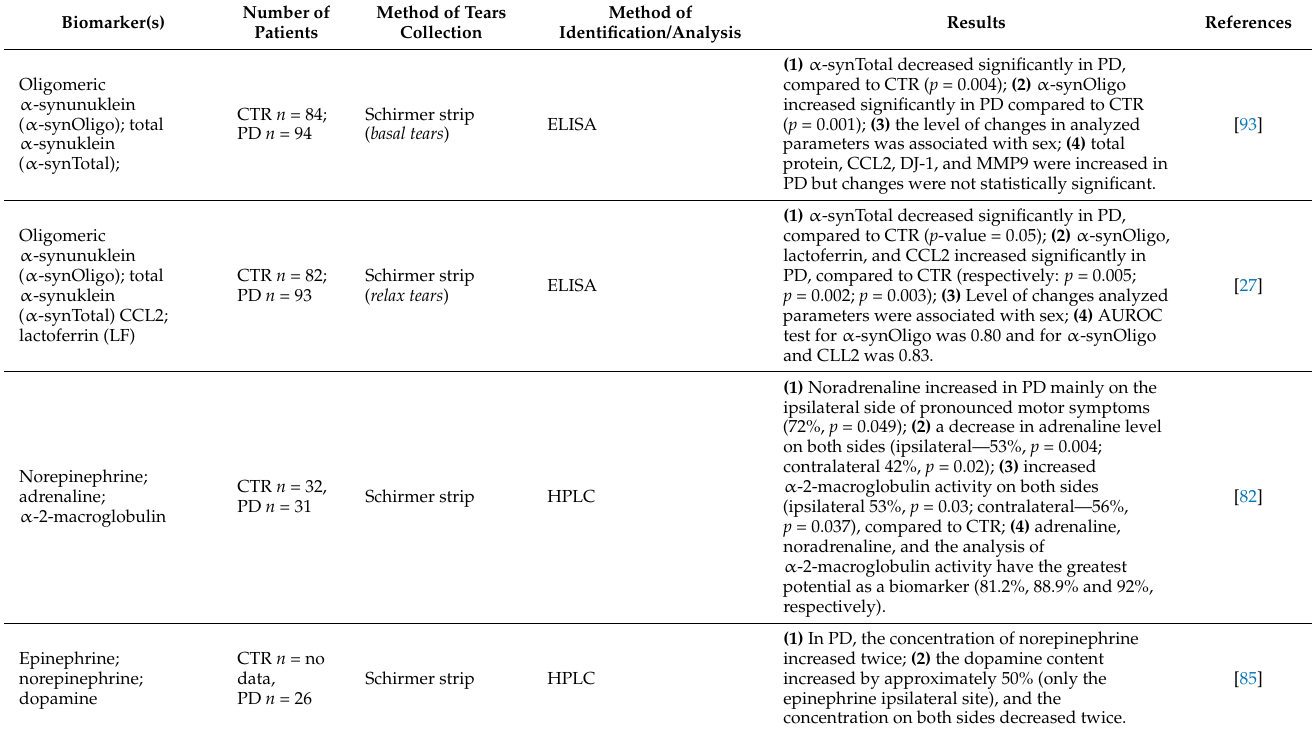
Table 2. Characteristic of biomarkers in Parkinson’s